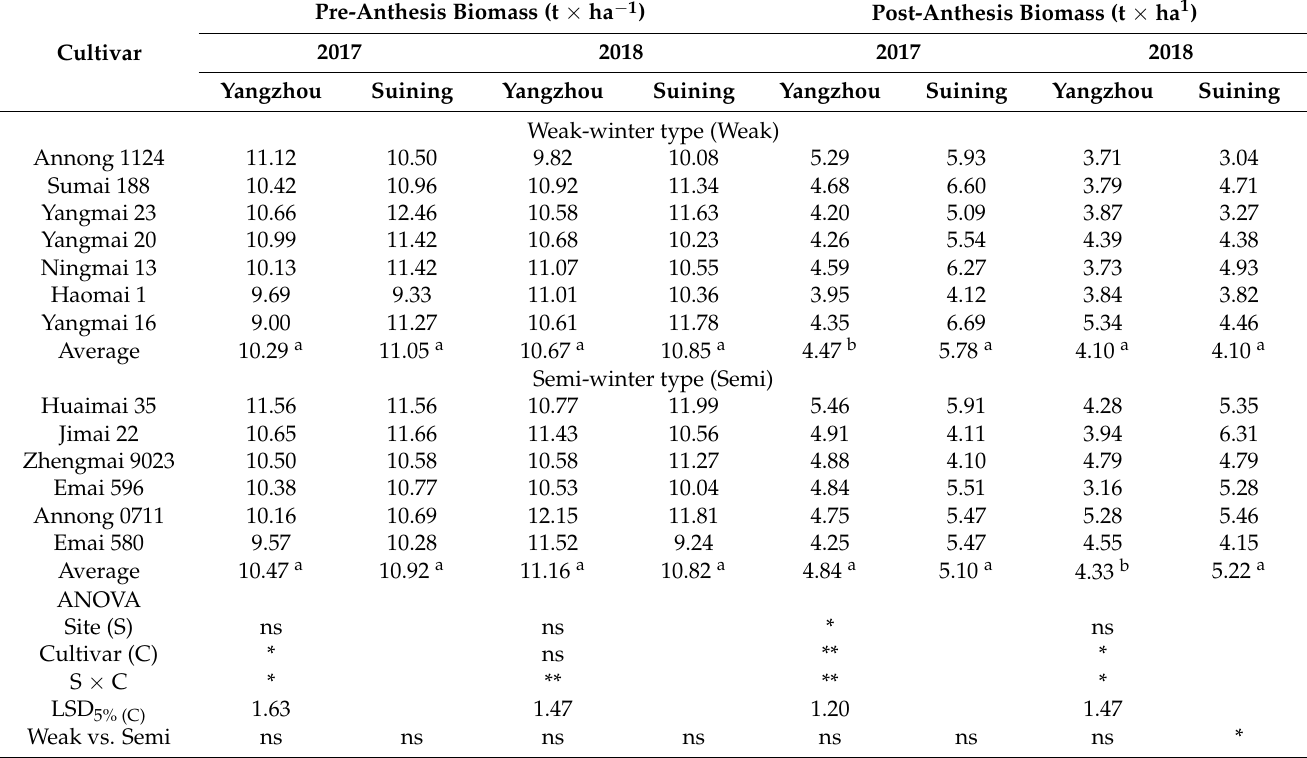
Table 9. Pre-anthesis and post-anthesis biomass (t ha − 1 ) of weak-winter-type and semi-winter-type cultivars planted in southern (Yangzhou) and northern (Suining) areas of the Yangtze River basin, China, in 2017 and